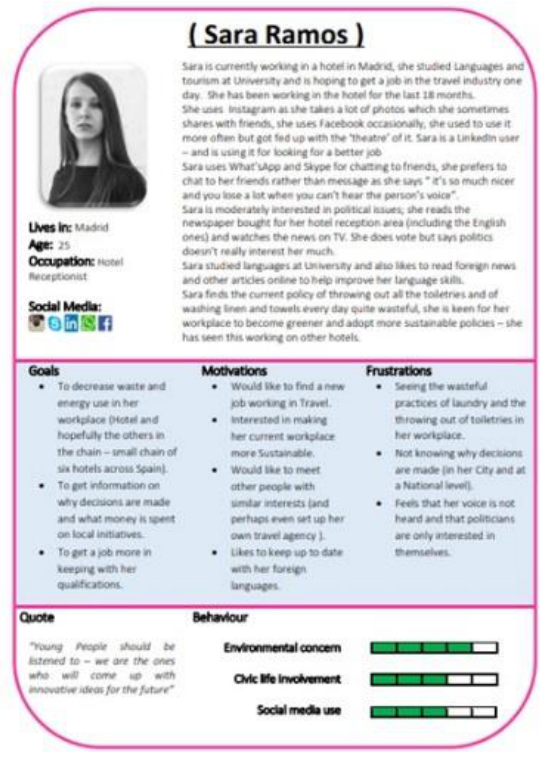
Fig. 2. Three personas from the STEP